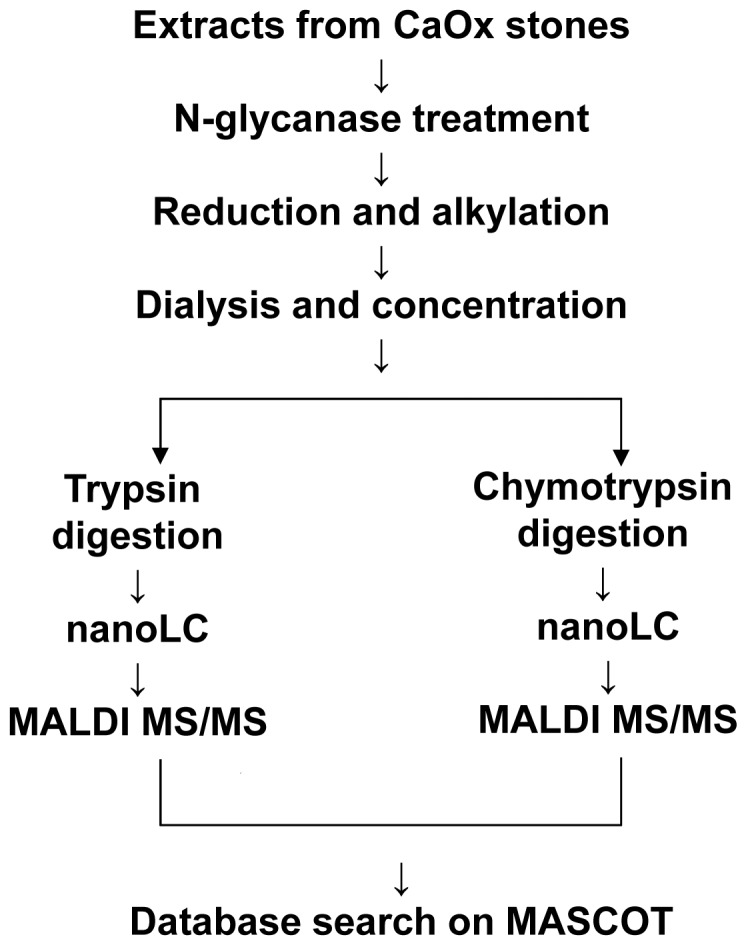
Procedure for protein profiling of CaOx renal stones.In order to analyze the protein compositions of individual CaOx stones, extracts from CaOx renal stones were subjected to protease digestion in solution and analyzed using nano-LC and MALDI-MS/MS as summarized in this scheme.